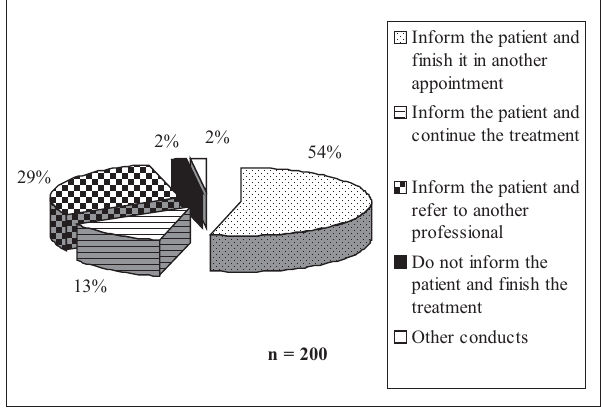
Fig. 1 - Professional conduct in case of endodontic instrument